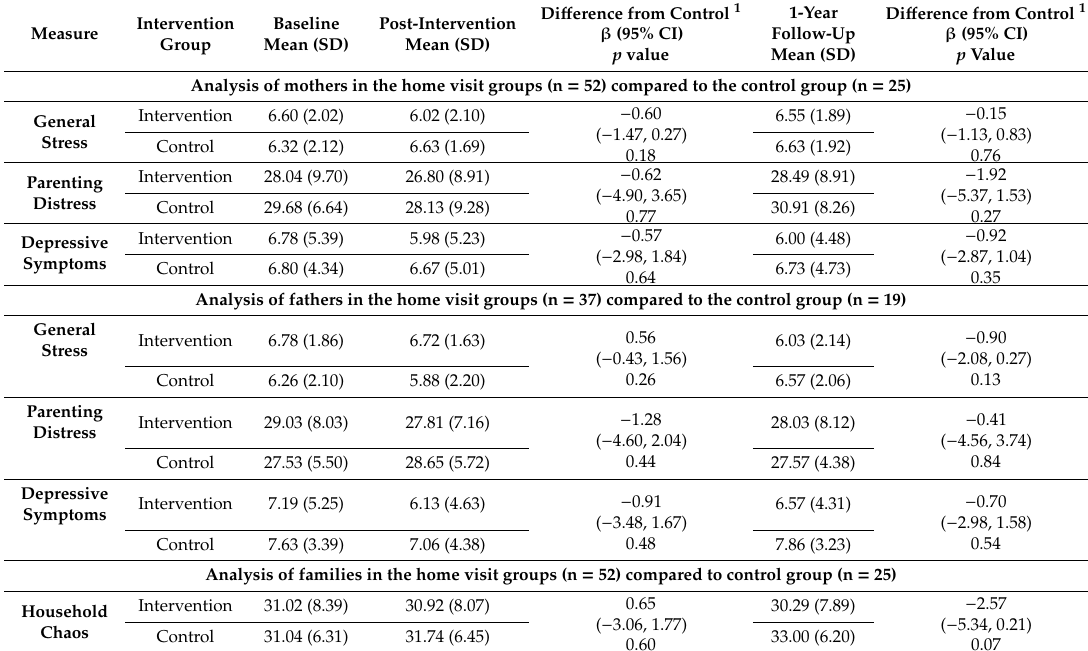
Table 2. Linear regression results comparing intervention and control groups with respect to stress levels at post-intervention and at 1-year follow-up after controlling for baseline, stratified by parent gender. Household chaos model analysed at the family level (one observation per